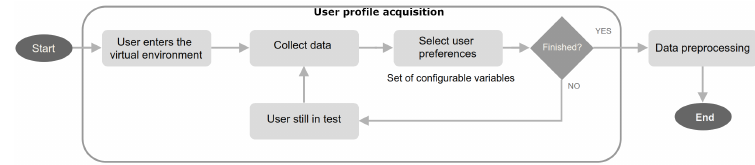
Figure 8. Elements of the user profile acquisition stage of the design phase.